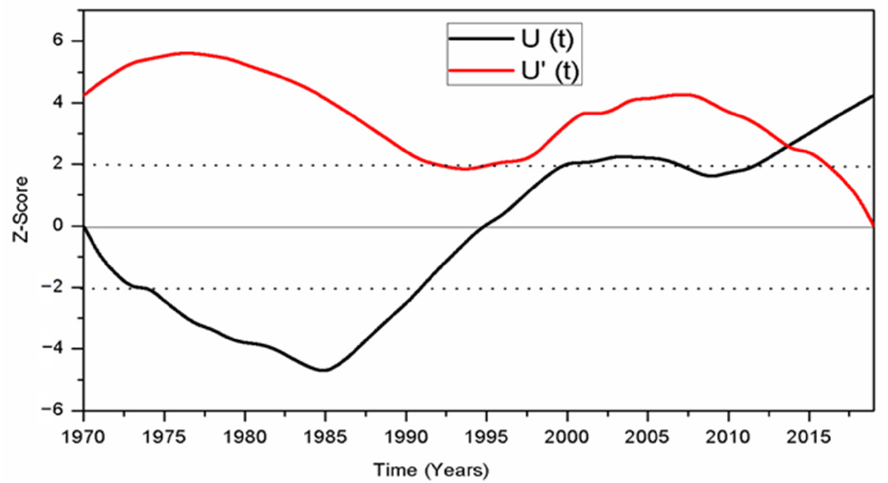
Figure 5. Abrupt change in heavy rainfall under NECV derived from the sequential Mann–Kendall test; U(t), forward sequential statistic; U’(t), backward sequential statistic; the upper and lower dashed lines represent significance at the 95% confidence level.